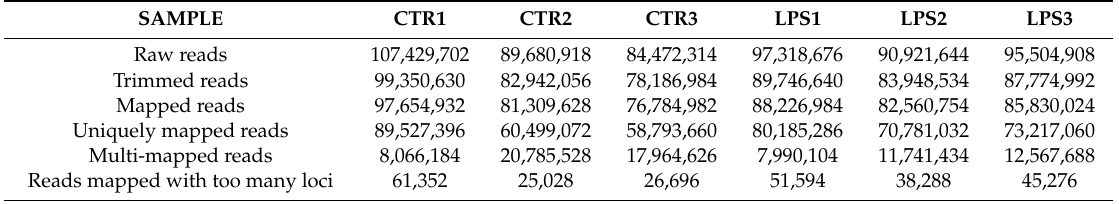
Table 1. Overview of the sequencing and mapping results for the six RNA-seq libraries. CTR 1, 2, 3 refers to the biological replicates of the control porcine endometrium; LPS 1, 2, 3 refers to the porcine endometrium after LPS administration; unique reads refer to the reads mapped to only one location of the porcine genome; multi-mapped reads refer to reads aligned to more than one locus on the reference genome; reads mapped with too many loci refer to the reads mapped more than 20 to multiple loci